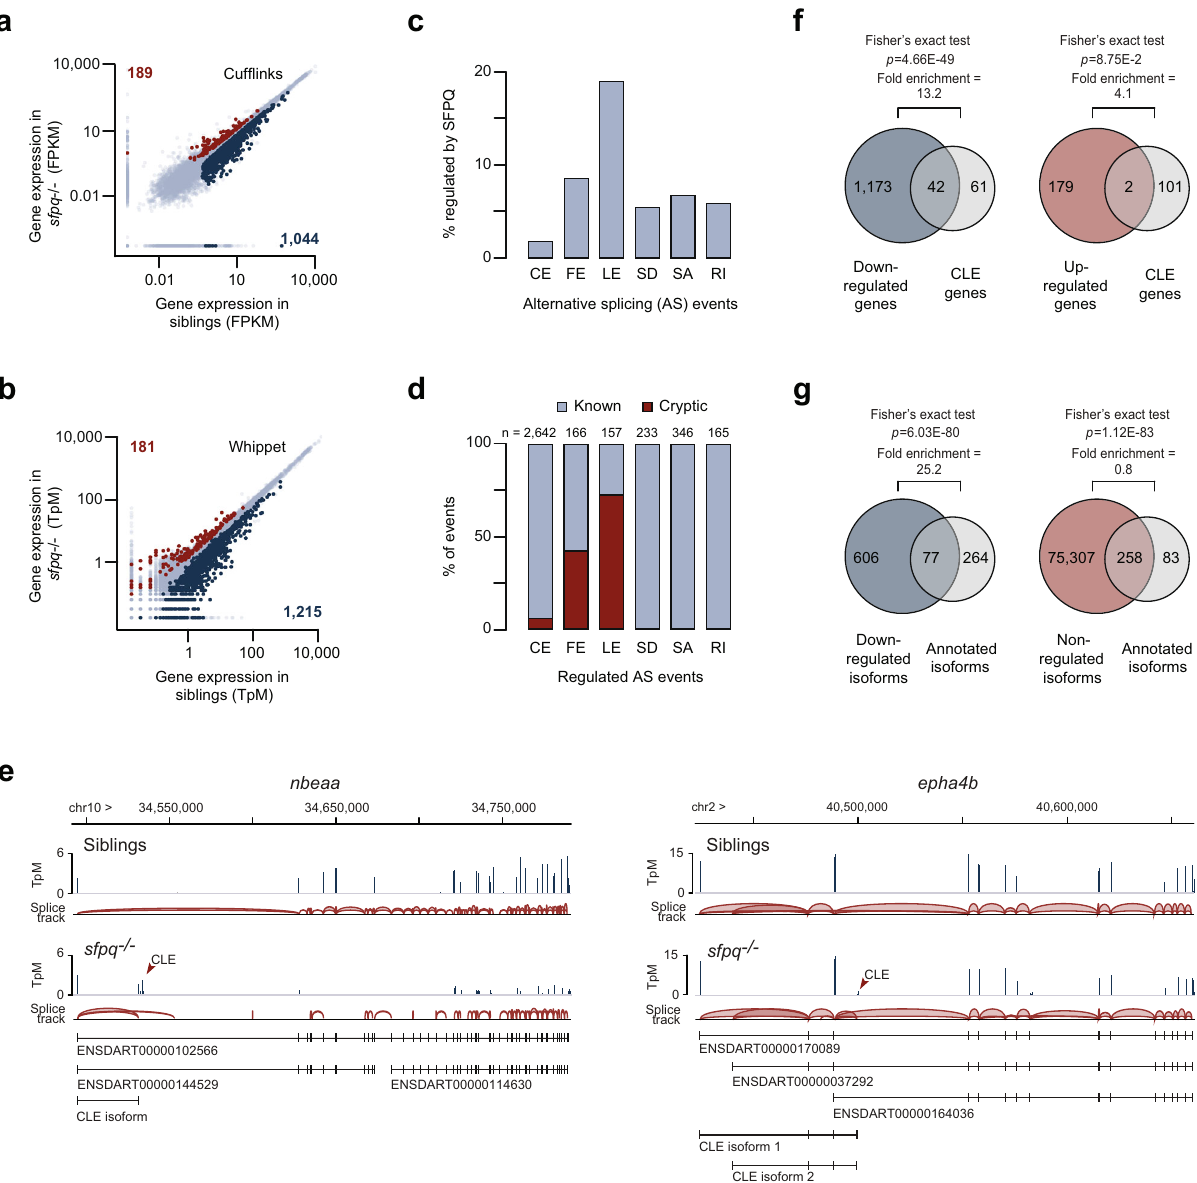
Fig. 1 SFPQ regulates the formation of cryptic last exons (CLEs). a , b Scatter plot showing expression values of genes in sfpq − / − and siblings, analyzed using Cuf fl inks ( a ) or Whippet ( b ) pipelines. FPKM fragments per kilobase of transcript per million, TpM transcripts per million. c Alternative last exons is a major category of SFPQ-controlled events. CE cassette exon, FE fi rst exon, LE last exon, SD splice donor, SA splice acceptor, RI retained intron. d Majority of SFPQ-regulated last exon events are cryptic. e Sashimi plots showing example CLE formation in nbeaa and epha4b . Top tracks: plot of read coverage from siblings (upper) and sfpq − / − (lower). Bottom tracks: isoforms discovered for each gene. f Genes expressing CLE-containing isoforms tend to be downregulated in sfpq − / − . Two-sided Fisher ’ s exact test was performed. g Normal long isoforms (annotated isoforms) from CLE-expressing genes tend to be downregulated in sfpq − / − . Two-sided Fisher ’ s exact test was